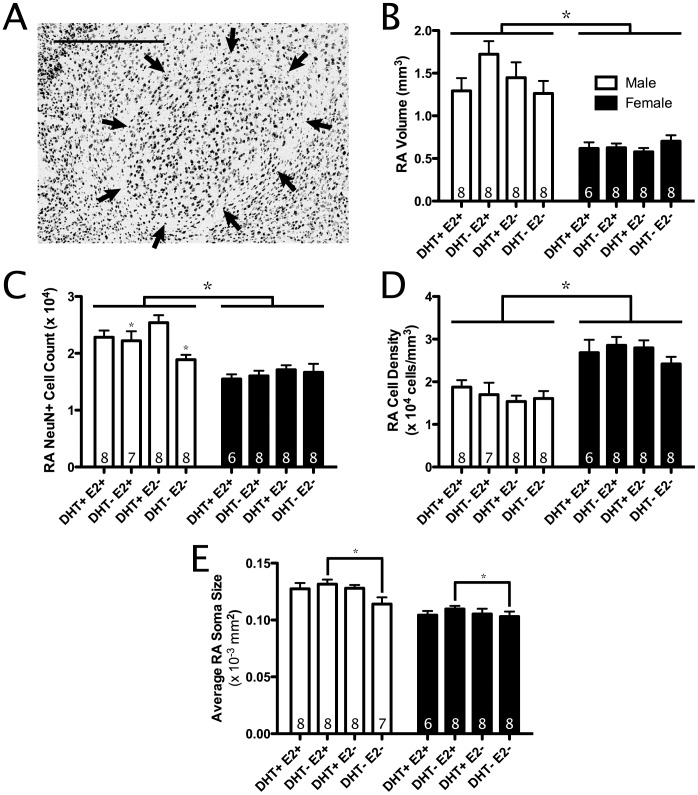
Effects of testosterone metabolites on anatomy of RA.A) Photomicrograph of RA in NeuN-stained (NeuN+) tissue. Nuclear borders indicated by black arrows. Scale bar = 500 µm. B) Volumes of RA across treatments. C) NeuN+ cell count in RA. D) Density of NeuN+ cells in RA. E) Average NeuN+ cell soma size in RA. All bars represent mean ± SEM. * <0.05. RA, robust nucleus of the arcopallium. In C), asterisks without connecting lines mark significant differences found using post-hoc analysis.